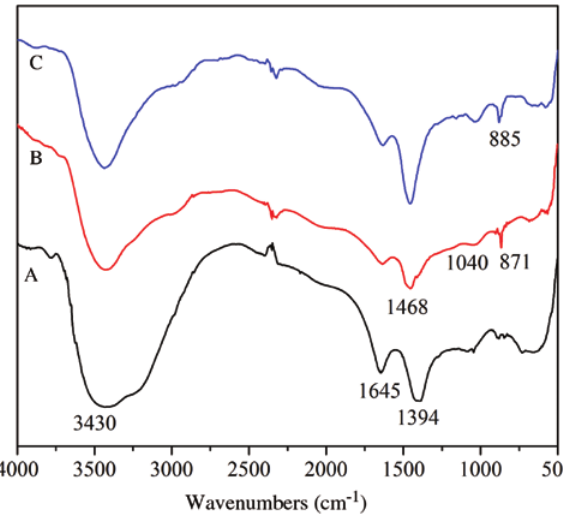
Figure 1: FTIR spectra of (A) pristine diamond, (B) KH550 modi- fied diamond in aqueous alcohol, (C) KH550 modified diamond in